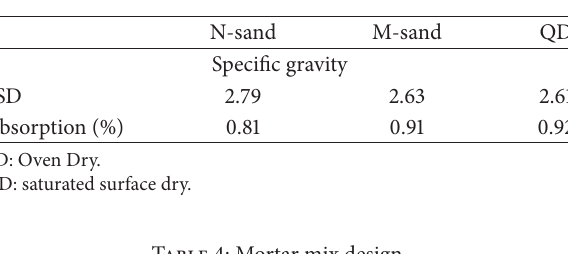
Table 4: Mortar mix